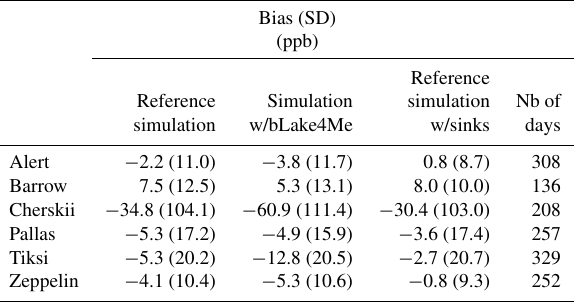
Table 6. Mean difference (and standard deviation) between ob- served and simulated CH 4 (in ppb) calculated on a daily basis at six continuous measurement